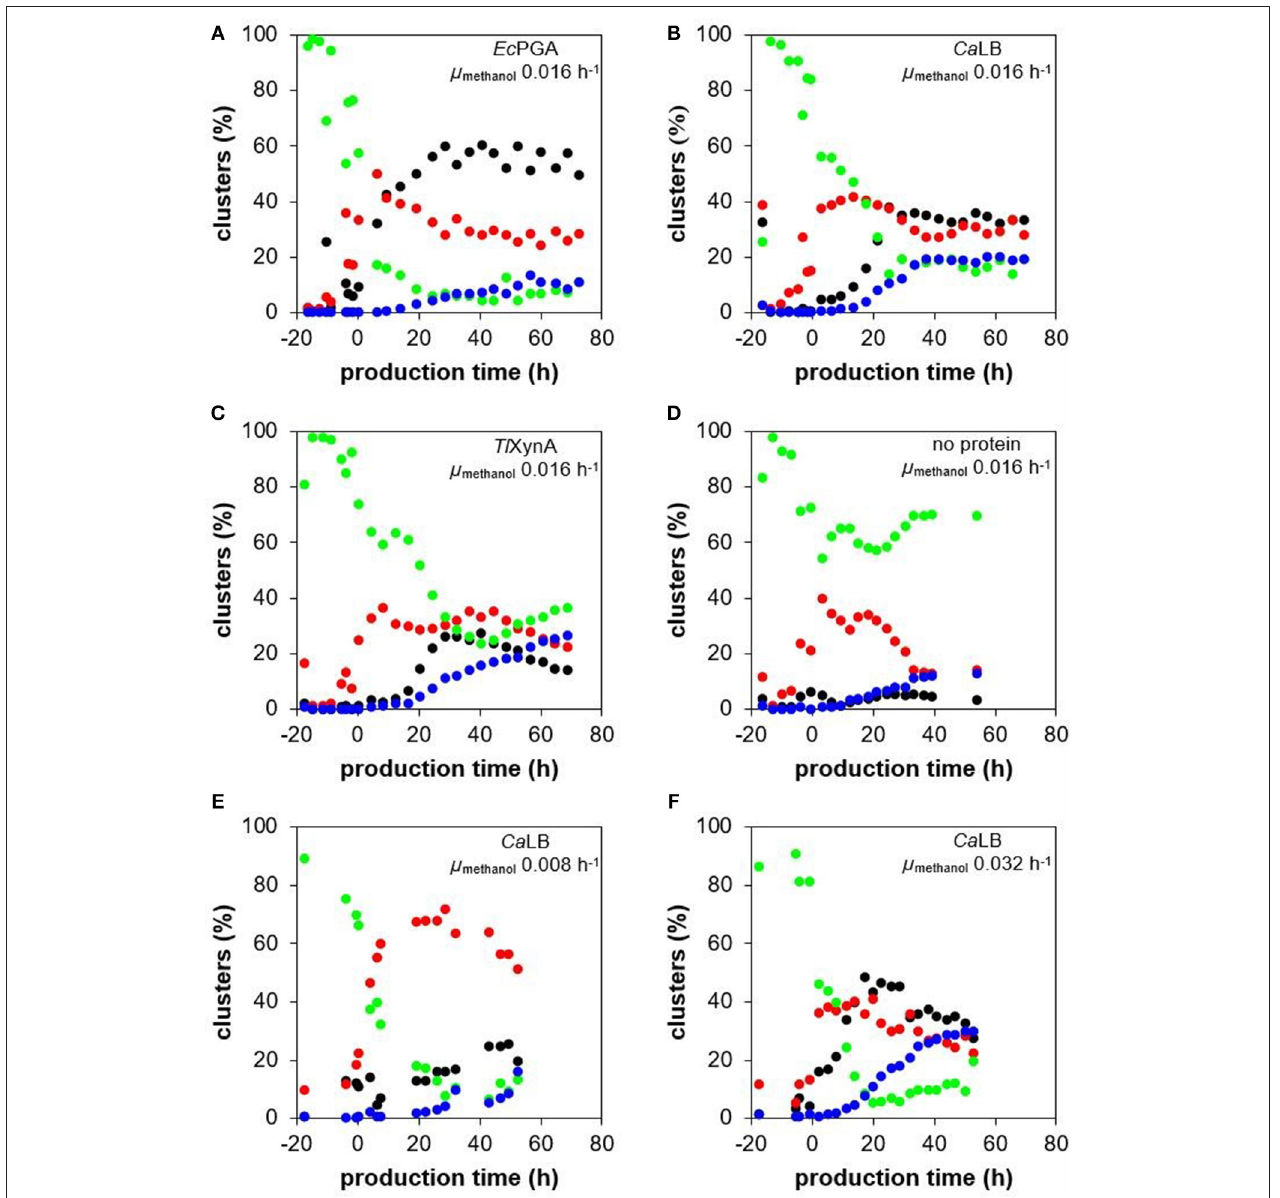
FIGURE 6 | Change of cell size and complexity, UPR up-regulation and viability during cultivations of P. pastoris strains producing different recombinant proteins. The P. pastoris strains producing Ec PGA (A) , Ca LB (B) , or Tl XynA (C) , as well as a control non-production strain (D) were cultured under the same cultivation conditions (30 ◦ C, pH 5.5), maintaining the specific growth rate of biomass with methanol at 0.016 h − 1 . Additionally, the P. pastoris strain producing Ca LB was cultured at 30 ◦ C, pH 5.5 and at a specific growth rate of biomass with methanol of 0.008 h − 1 (E) and 0.032 h − 1 (F) . The four sub-populations identified with the PCA of the flow cytometric data were observed in all the cultivation processes: smaller and less complex viable cells with no UPR up-regulation (red ovals); larger and more complex viable cells with no UPR up-regulation (green ovals); viable cells with up-regulated UPR (black ovals); and cells with an impaired viability (blue ovals).